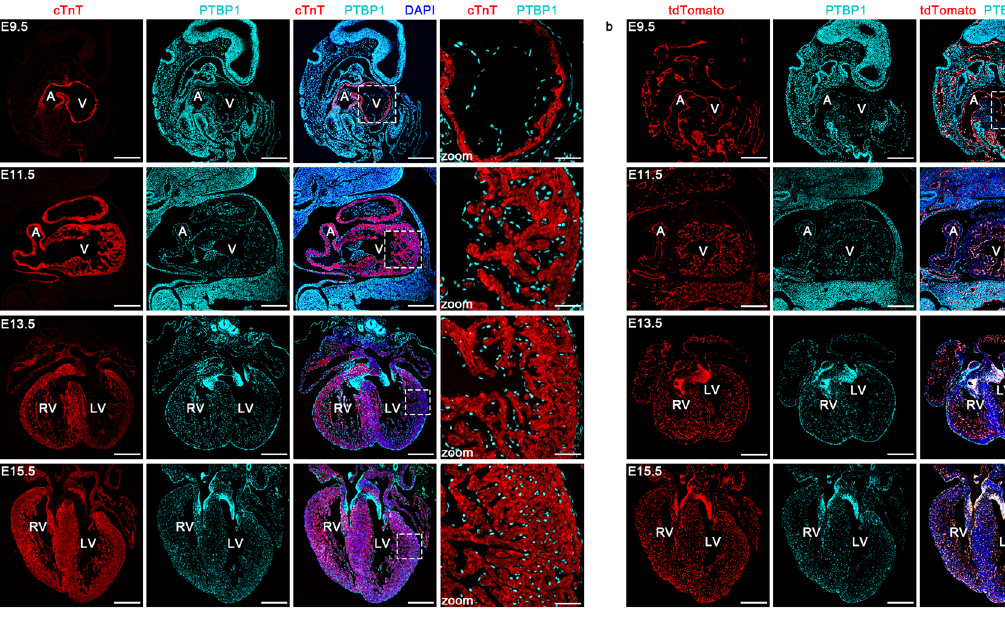
Fig. 1 | The colocalization of PTBP1 with endothelial cells during heart devel- opment. a Immuno fl uorescence staining of PTBP1 (cyan) with the cardiomyocyte marker cTnT (red) in embryonic hearts. The magni fi ed images indicate the dis- tribution pattern of PTBP1 inventriculartissues. The expression of PTBP1 isalmost undetectable in cardiomyocytes. b Immuno fl uorescence staining of PTBP1 in Tie2- Cre ; Rosa26 -tdTomato embryonic hearts. The magni fi ed images indicate the colo- calization of PTBP1 (cyan) with tdTomato-marked endothelial cells (red) in Tie2-